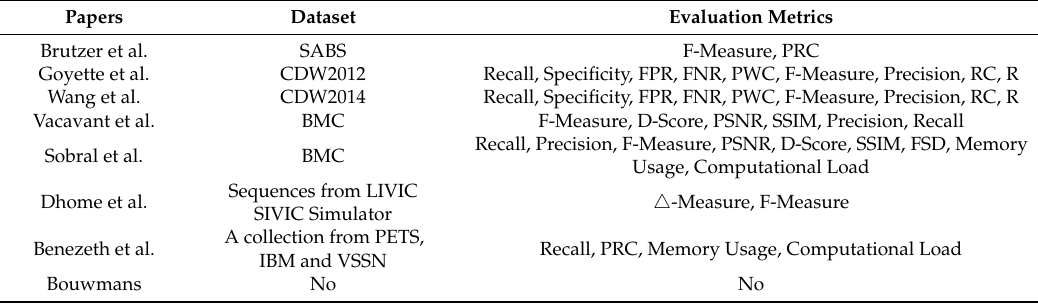
Table 2. Introduction of recent evaluation and review papers on background subtraction.